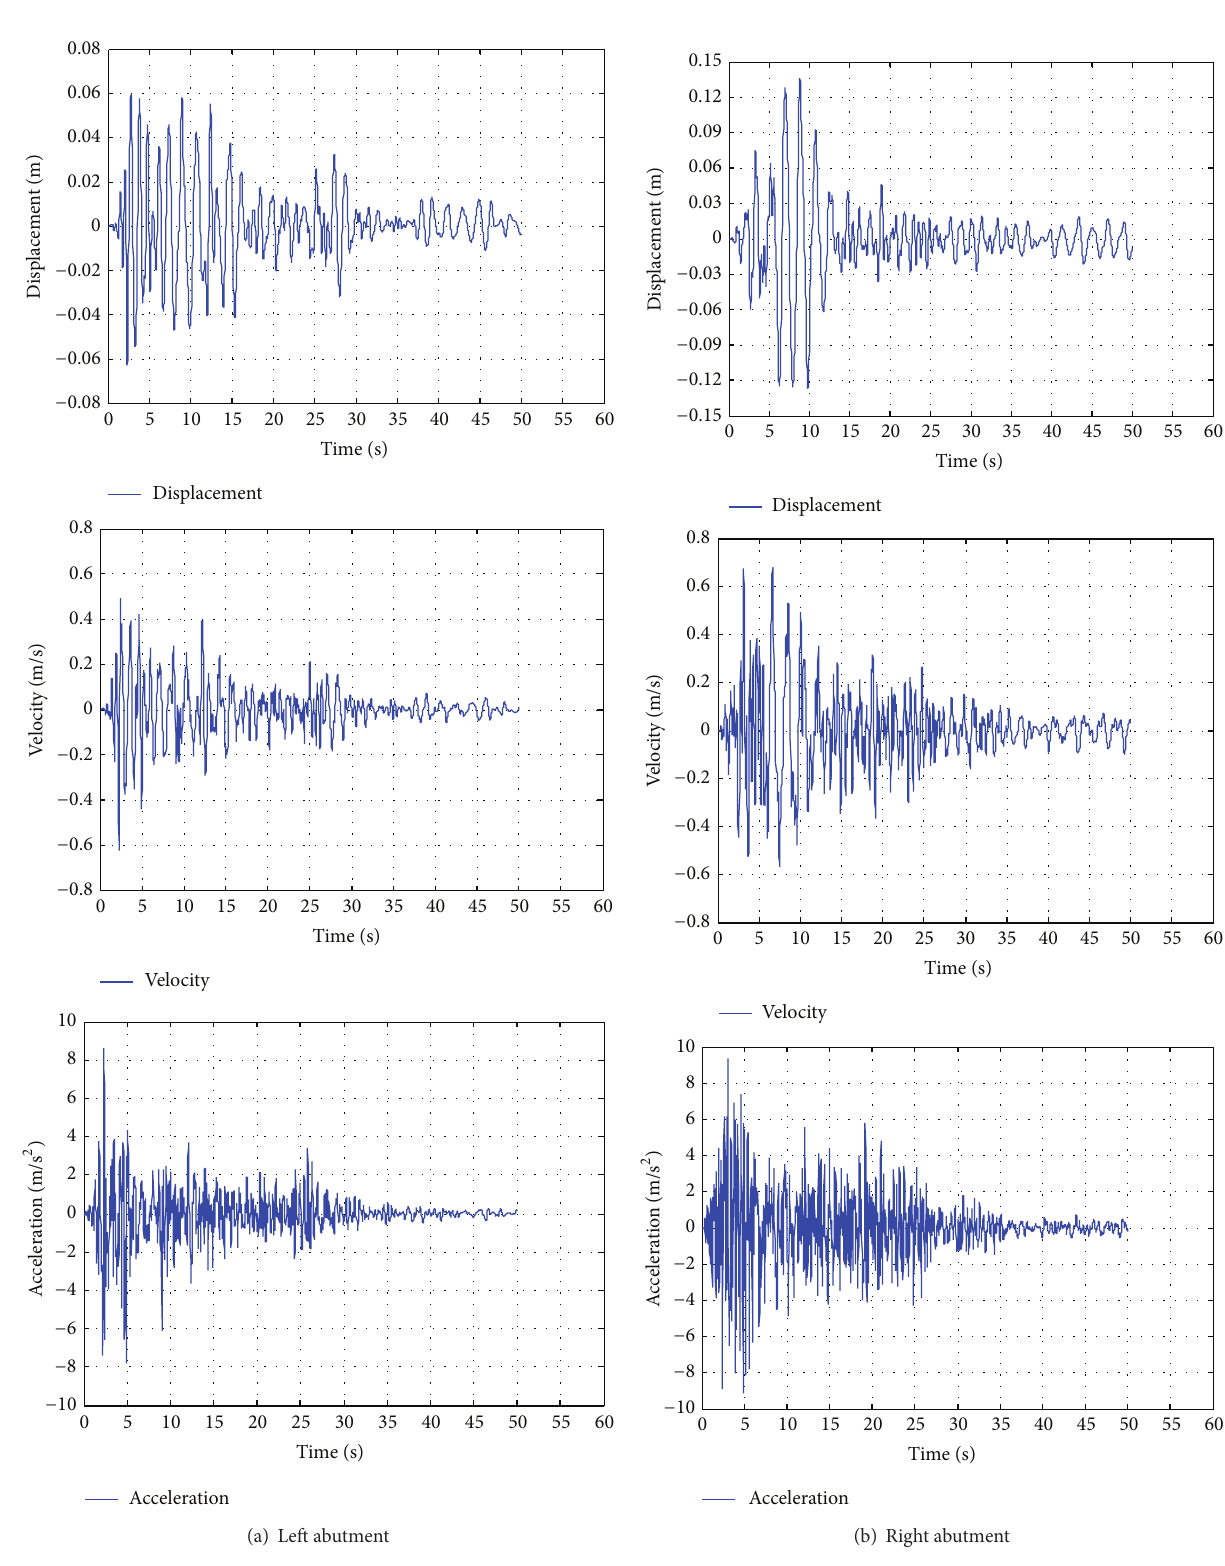
Figure 5: Dynamic responses of abutments ( 𝑉 𝑤 =